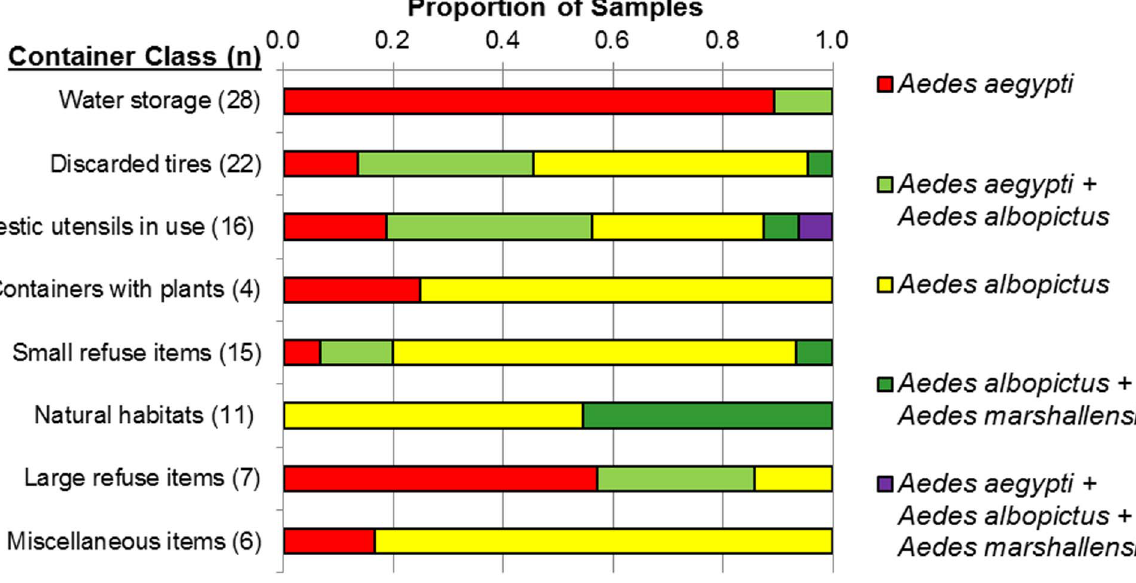
Figure 5. Aedes species composition in juvenile mosquito samples collected from water-filled containers on Majuro atoll, Republic of the Marshall Islands, 3–8 November, 2011. Examples of habitat types in each container class are provided in Table 2.